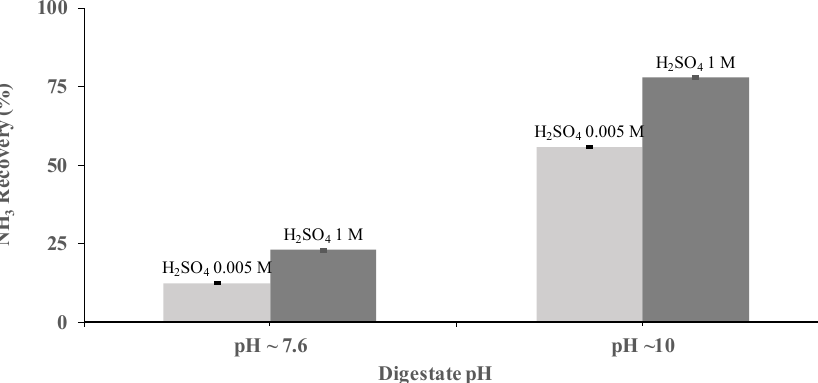
Figure 3. Influence of the sulfuric acid concentration on NH 3 recovery from SD at pHs of 7.6 and 10 and a flow rate of 0.030 m 3 h − 1 using the PTFE-0.22 membrane. Vertical bars (very short here) represent the standard deviation from replicate measurements.